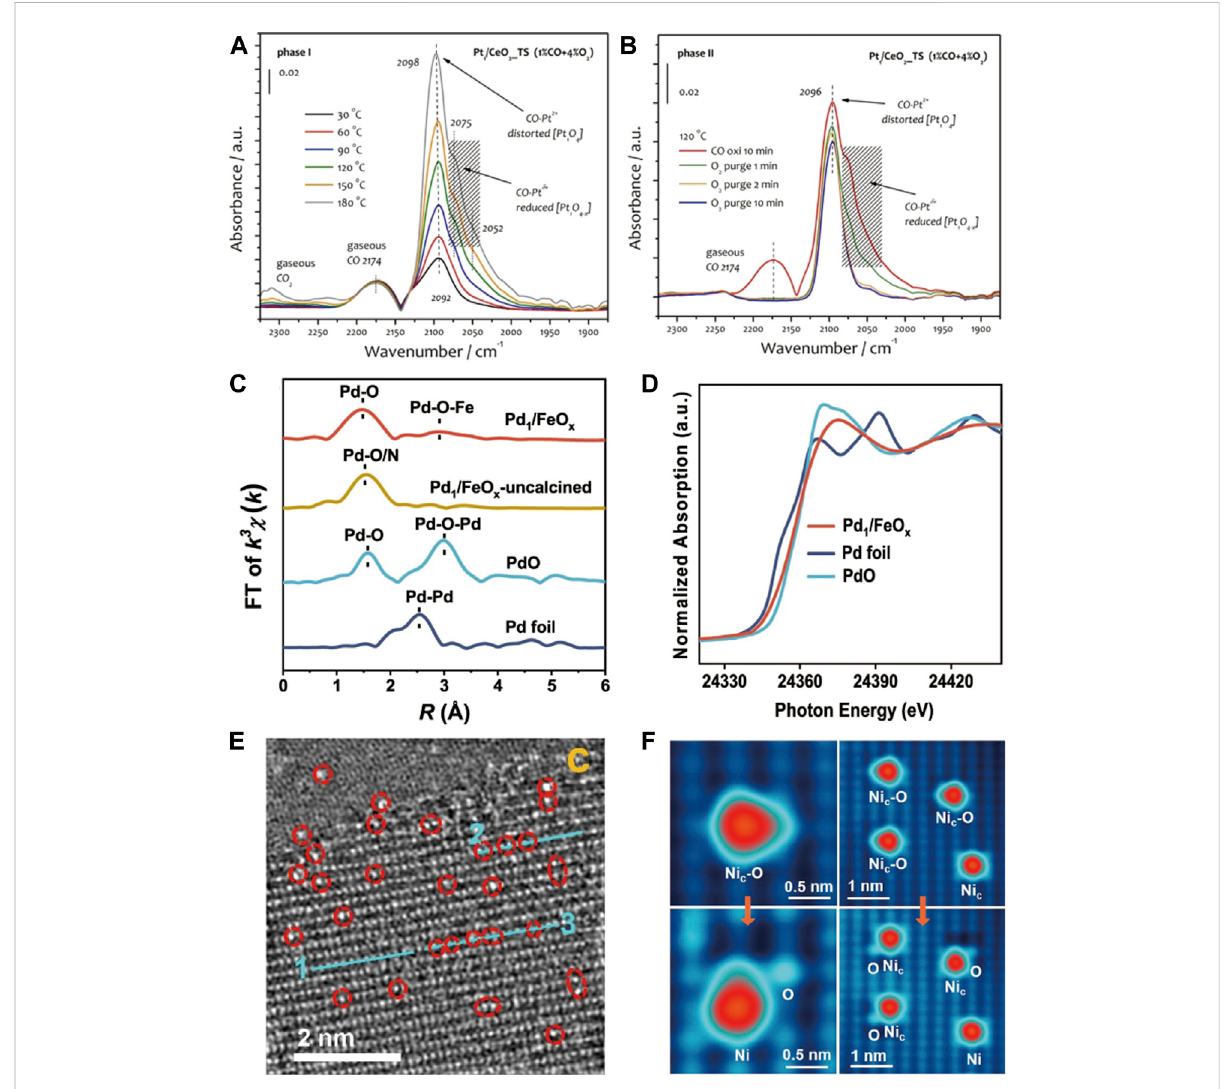
FIGURE 4 CO-DRIFTS of Pt 1 /CeO 2 _TS catalysts (A) in CO oxidation, followed by O 2 /He purging (B) . Reprinted from Jiang et al. (2021b). Copyright © 2021, with permission from Wiley-VCH GmbH. The k 3 -weighted Fourier-transform spectra from EXAFS (C) and normalized XANES spectra (D) at Pd K-edge. Reprinted from He et al. (2022). Copyright © 2022, with permission from Springer Nature. (E) HAADF-STEM image of Cu single-atoms anchored on TiO 2 . Reprinted from Zhang Y. M. et al. (2022). Copyright © 2022, with permission from Springer Nature. (F) STM image of “ Ni c -O ” species formed in O 2 at room temperature and “ Ni c -O ” species can be split after pulsed-voltage manipulation. Reprinted from Zhou J. et al. (2022). Copyright © 2022, with permission from American Chemical